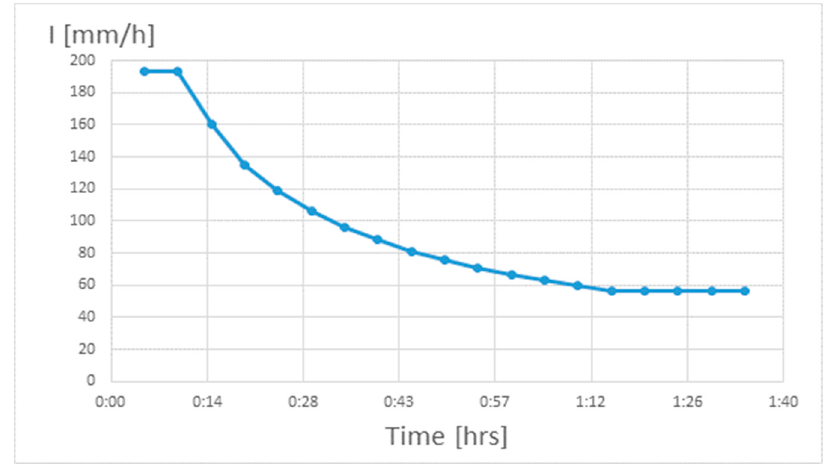
Figure 3. IDF Curve of the actual project rain.